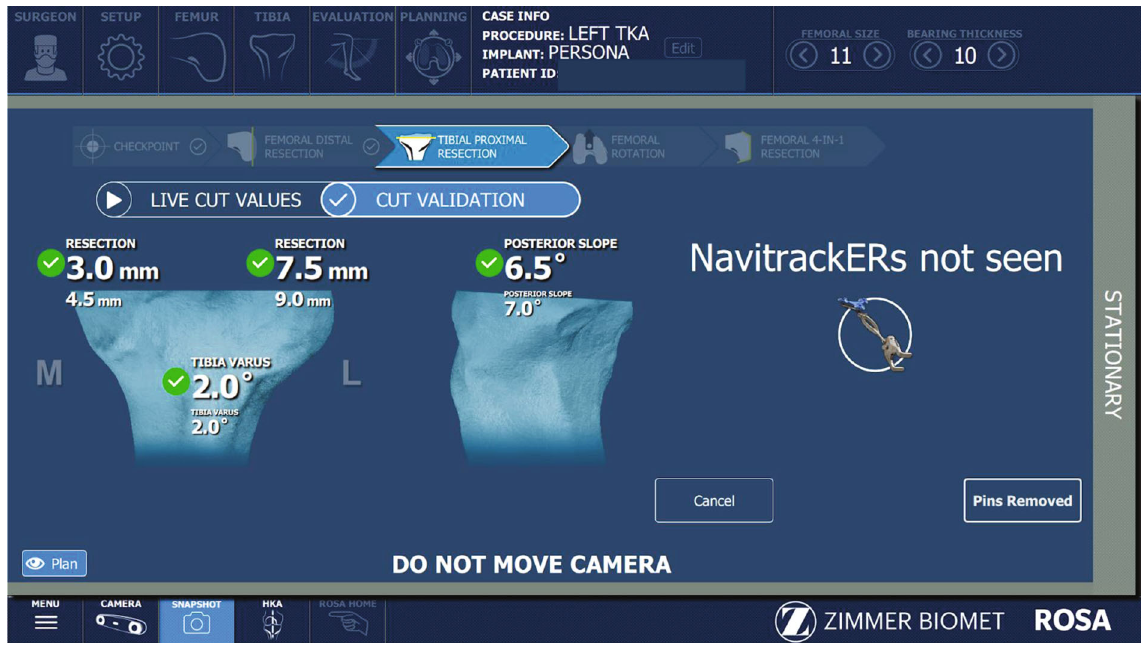
Figure 9: Final proximal tibial resections validated against the planned resections for Case 3.